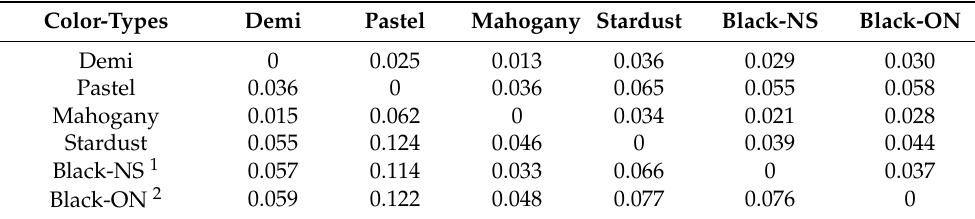
Table 3. Estimation of Nei’s genetic distance (upper diagonal) and Weir and Cockerham’s Fst (lower diagonal) between different color-types of American mink.